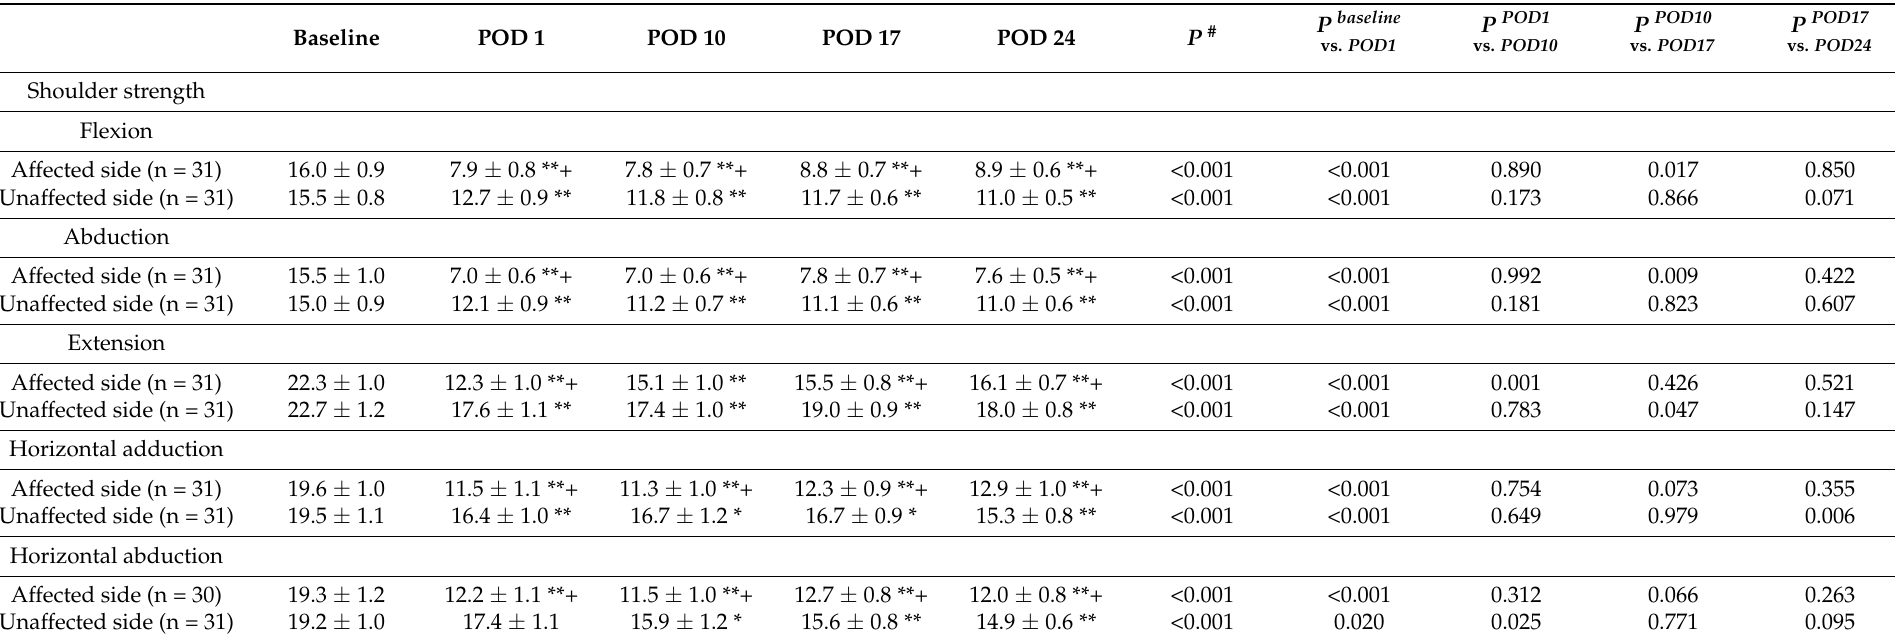
Table 3. Change of shoulder strength (pre-surgery to 4 weeks